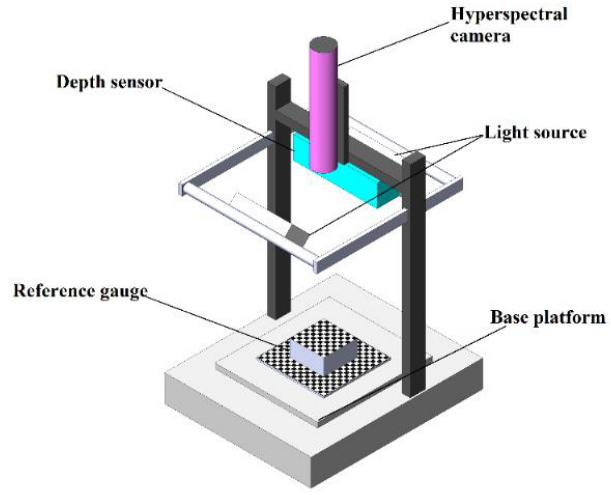
Figure 3. The structure of imaging station.